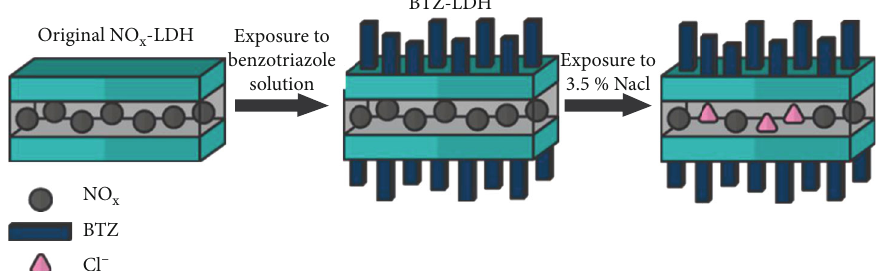
-LDH until BTZ-LDH obtainment and its posterior exposition to x